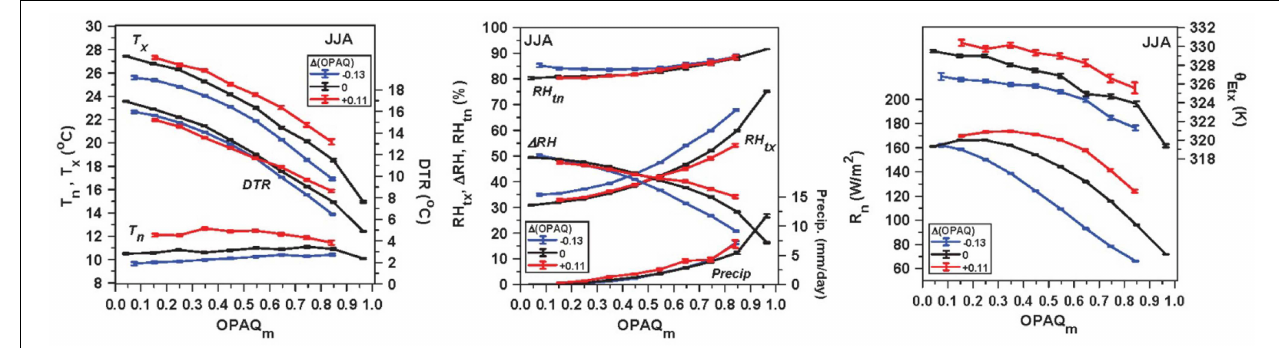
FIGURE 10 | Coupling of daily climate to OPAQ m and 1